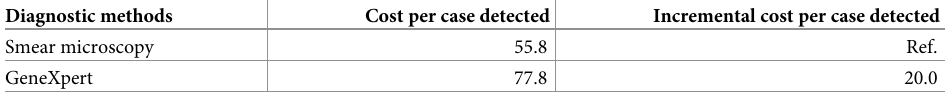
Table 4. Incremental cost-effectiveness ratios of GeneXpert compared to smear